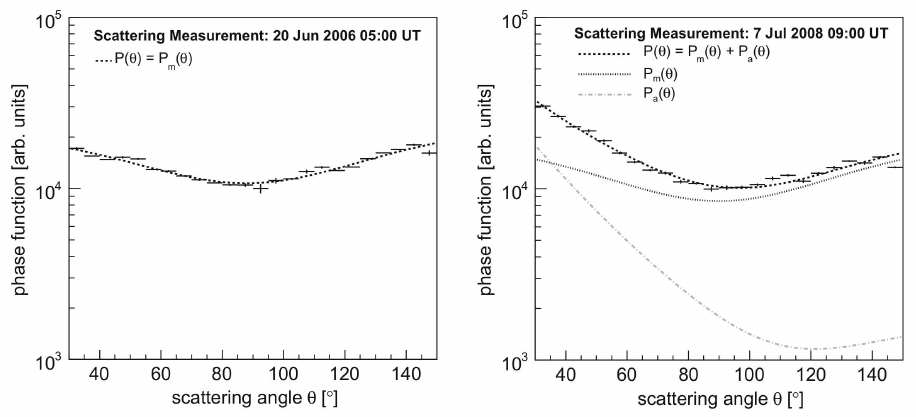
Figure 6. Aerosol Phase Function (APF) light intensity vs scattering angle is shown for an aerosol-free night (left) and for a typical night